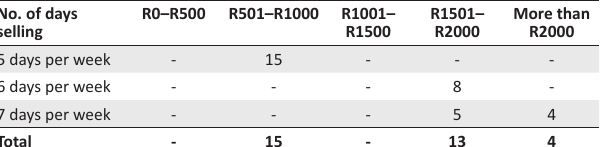
TABLE 1: Relationship between number of days selling and income per week.